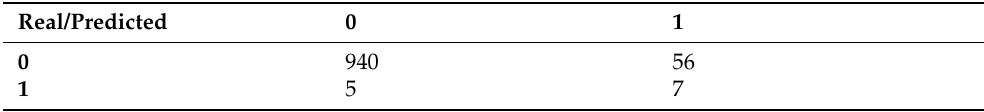
Table 4. Confusion Matrix (DT).